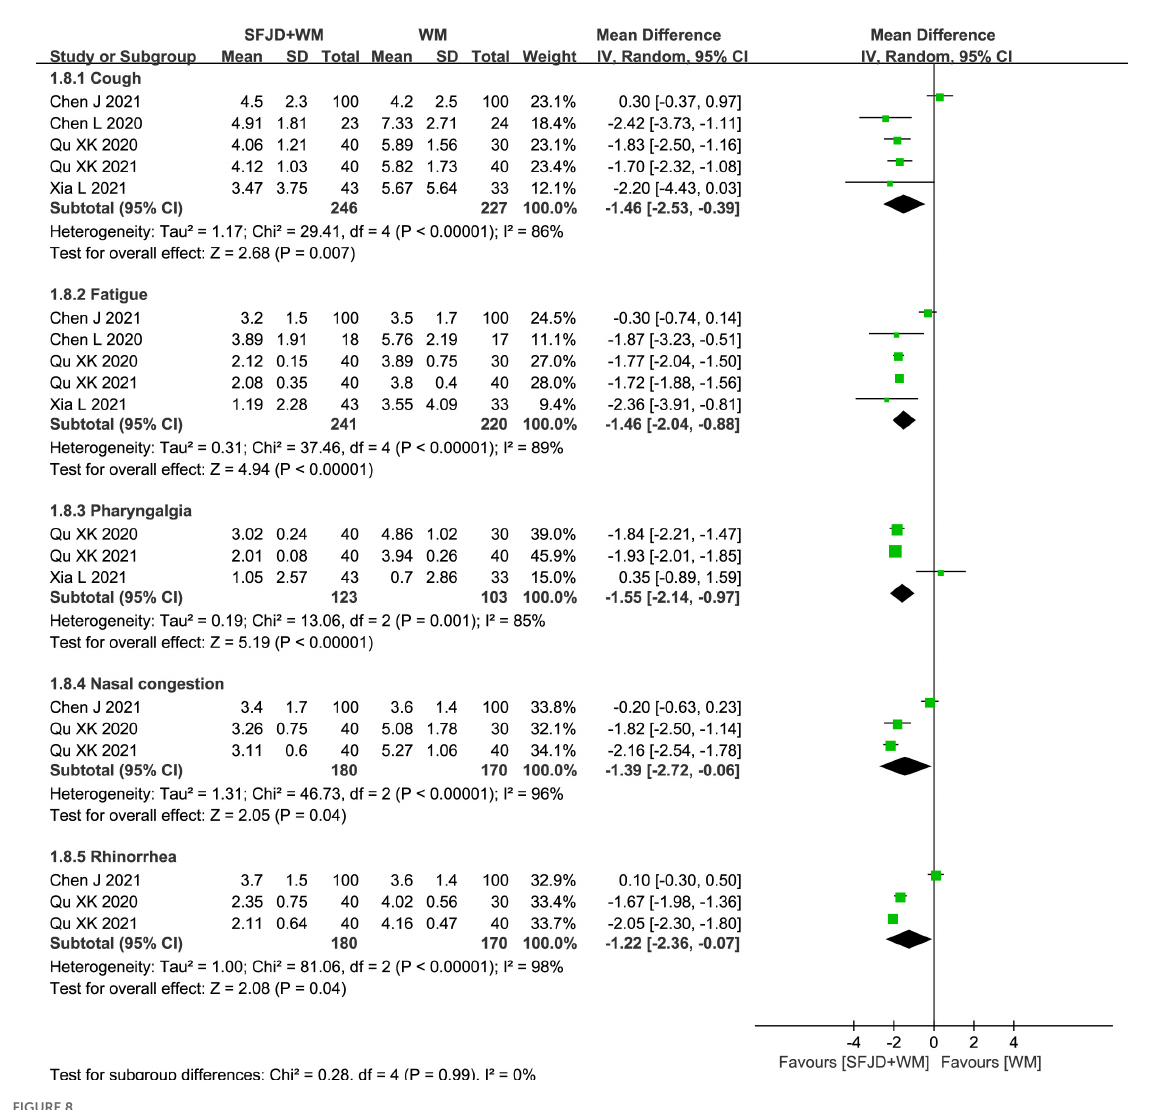
FIGURE8 Meta-analysis on symptom disappearance time in the SFJD + WM group vs. the WM group in COVID-19 patients (random effect